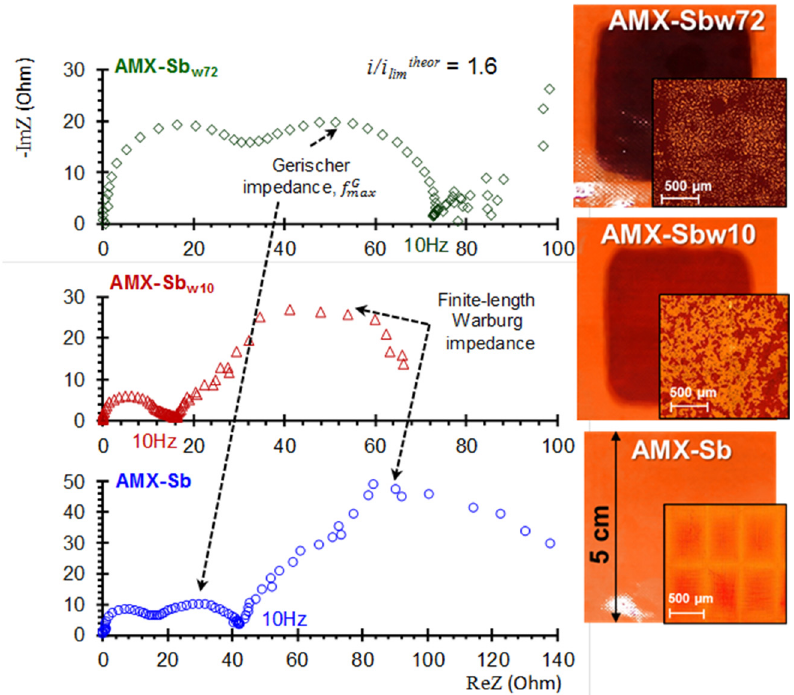
Figure 9. Electrochemical impedance spectra of pristine anion exchange membrane AMX-Sb and the same membrane after contact with wine for 10 (AMX-Sb w10 ) and 72 (AMX-Sb w72 ) hours. The data were obtained in 0.02 M NaCl solution; on the right are optical images of the studied samples. Adapted from [62].